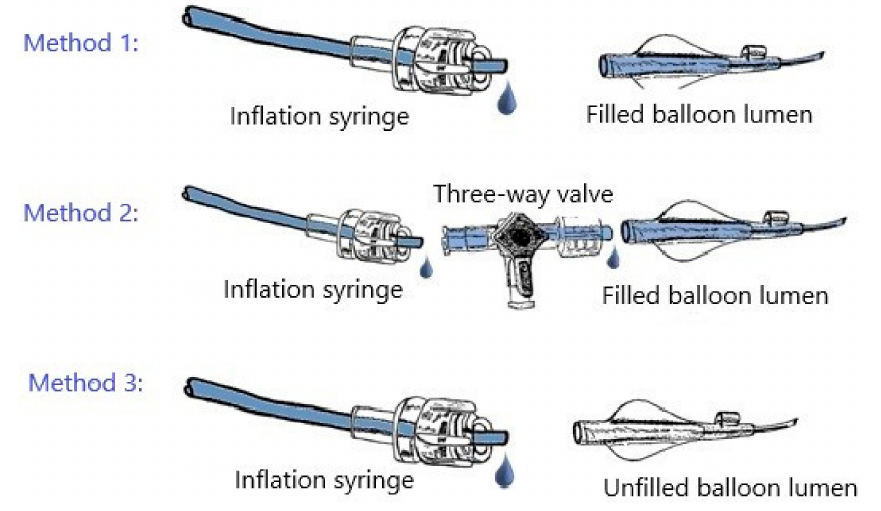
Figure 1. Methods of connecting the balloons.